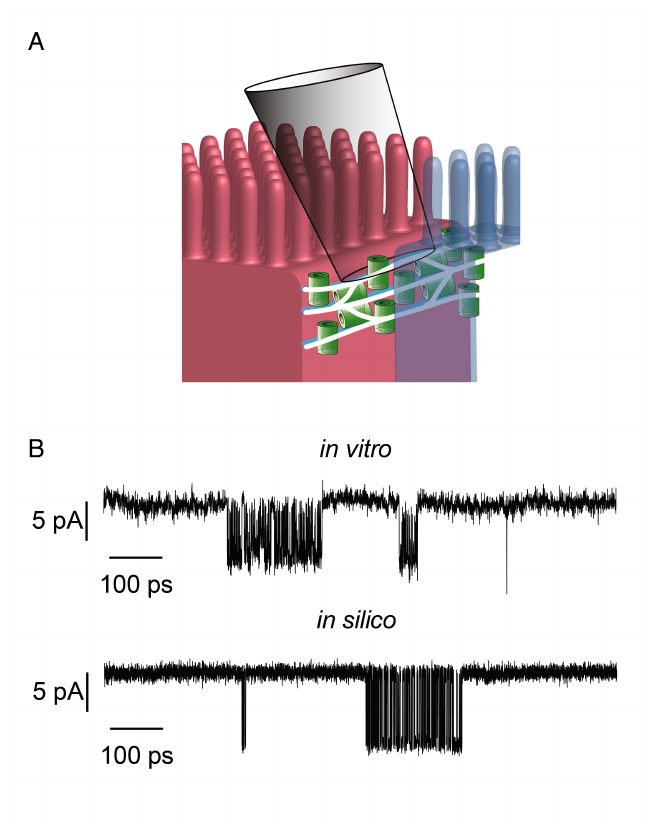
Figure 1. Mathematical modeling of tight junction permeability. ( A ) Electrodes were sealed over the intracellular space between MDCK I induced to express claudin-2 [12]. Each claudin-2 pore was defined by two closed states (C 1 , C 2 ) and a single open state (O) according to the equation in [14] ( B ) In silico patch clamp recordings resembled in vitro tight junction patch clamp recordings from MDCK I monolayers expressing claudin-2 (recording from dataset of Weber et al. [12]). For the simulation, each green pore shown in panel A was modeled as 36 resistors per micron with defined opening and closing probabilities